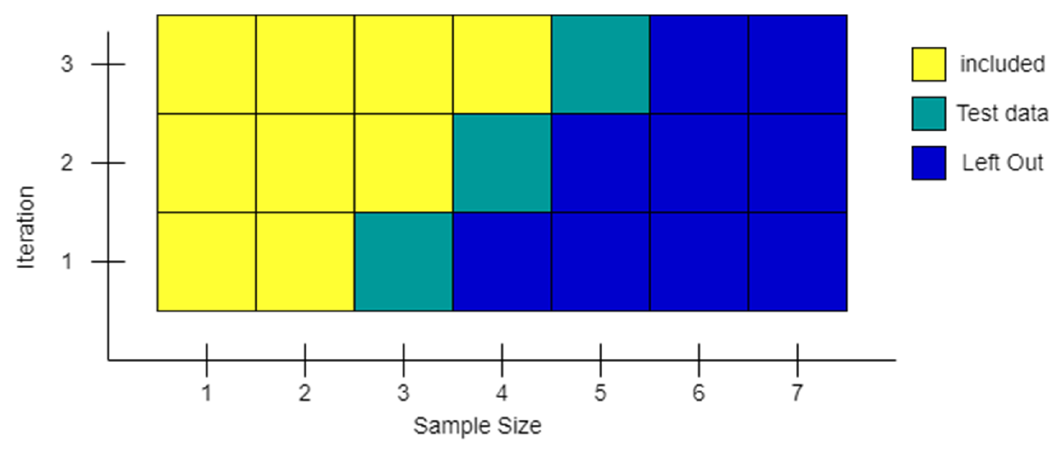
Figure 12. Nested Cross Validation for a time series (adapted from [35]).